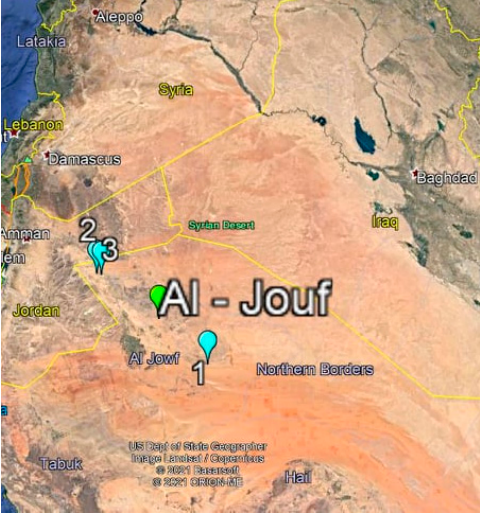
Figure 1. Map of Saudi Arabia showing the three soil sampling sites (Dumat Al-Jandal; Qasr Kaff and Ain Hawas Regions) of the Al-Jouf Region area.